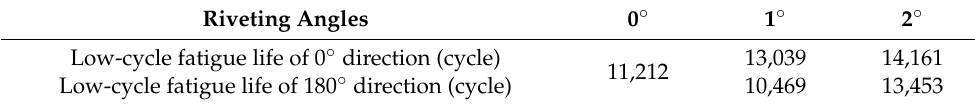
Table 6. Low-cycle fatigue life of riveted joints at different riveting angles and directions. Riveting Angles